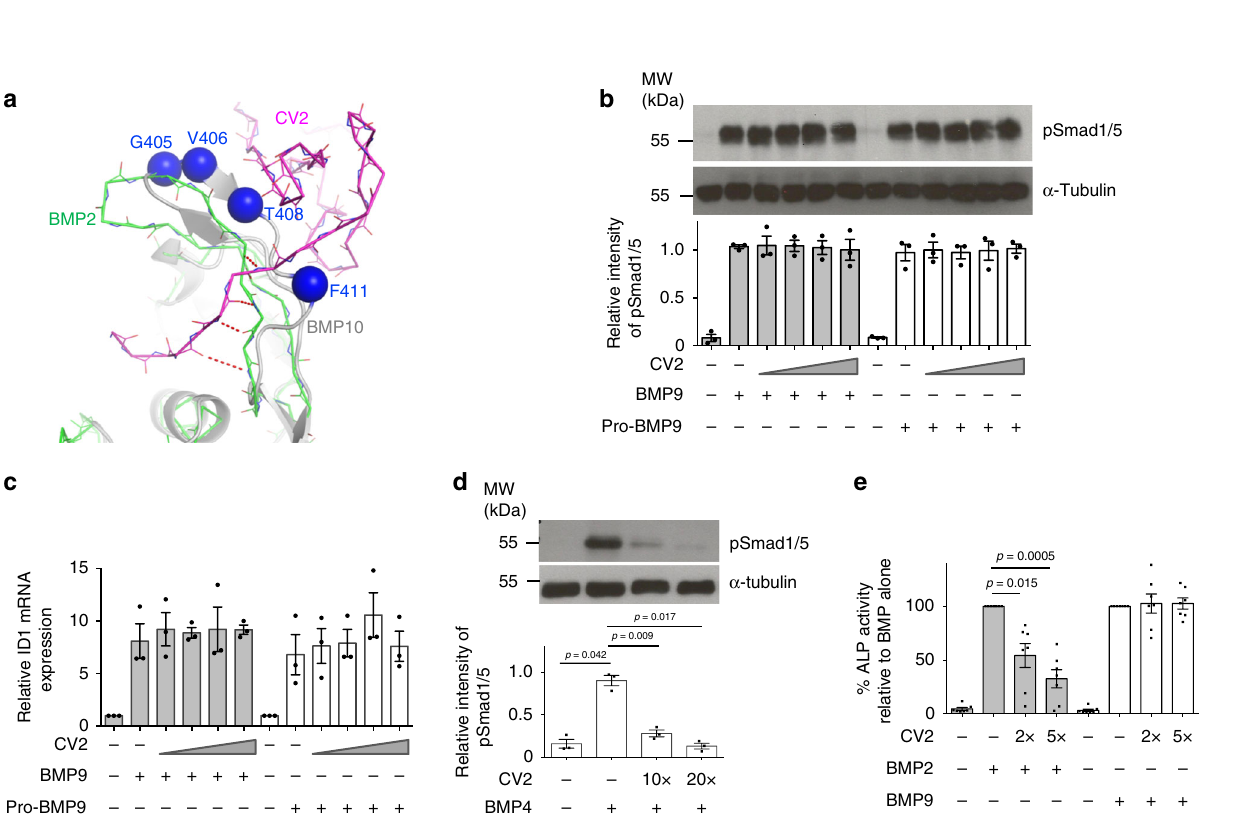
Fig. 6 ALK1 can form a complex with pro-BMP9. a Overall structure of the human pro-BMP9:ALK1 complex at 3.3 Å (BMP9 in green, ALK1 in magenta, prodomain in orange) overlaid onto the pro-BMP9 structure (4YCG, grey, semi-transparent). b Backbones of the BMP9:ALK1 portion from the pro-BMP9: ALK1 structure (BMP9 in green, ALK1 in magenta) overlaid onto the same region in the BMP9:ALK1:ActRIIb structure (4FAO, grey). c Overlay of the two prodomains from the pro-BMP9:ALK1 structure (shown in cartoon and coloured in orange and grey respectively) and that from 4YCG (in ribbon, cyan). d In the pro-BMP9:ALK1 structure, the conserved region 2 in BMP9 makes the same four backbone H-bond interactions with the prodomain as shown in Fig. 5e. Four residues in the conserved region 2 are shown in blue spheres and labelled with BMP10 numbering. e – h Analysis of complex formation by analytical gel fi ltration. Puri fi ed pro-BMP9, pro-BMP9 mixed with ALK1, pro-BMP9 mixed with sENG and sENG were run separately on an S200 10/300 gel fi ltration column which was pre-equilibrated with 20 mM Tris.HCl, 150 mM NaCl, pH 7.4. e Gel fi ltration traces. The arrows indicate the elution volumes of the standards. Numbers 1-6 indicate the 6 peaks which were analysed by SDS-PAGE. f Middle fraction from each peak was run on an SDS-PAGE. Identities of the proteins on the SDS-PAGE are indicated using coloured circles. g Consecutive fractions from each gel fi ltration experiment were run on a non- reducing SDS-PAGE and immunoblotted using an anti-BMP9 prodomain antibody. Each analytical sample run was repeated at least one more time with fraction checked on SDS-PAGE to ensure reproducibility. h Cartoon diagrams, using the same colouring scheme as the circles in f , to illustrate that mixing pro-BMP9 with ALK1 leads to the formation of pro-BMP9:ALK1 complex, whereas mixing pro-BMP9 with sENG leads to the displacement of the prodomain which can be readily detected as a different peak in the gel fi ltration.